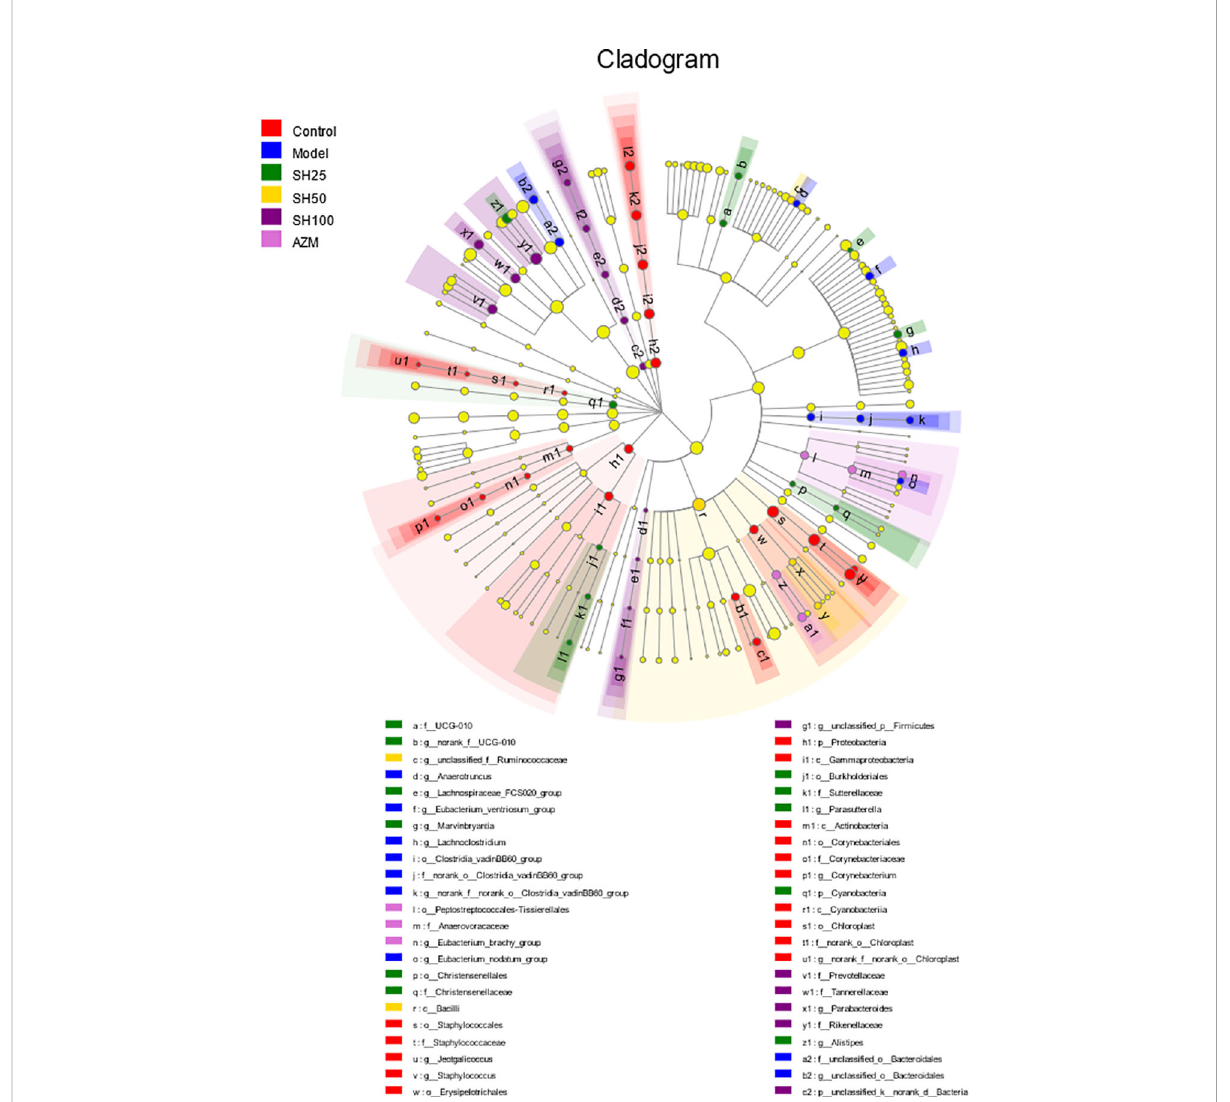
FIGURE 8 Multilevel species hierarchy tree diagram for LEfSe analysis. Different color nodes represent the microbial groups that are signi fi cantly enriched in the corresponding groups and signi fi cantly in fl uence the differences between groups. The pale yellow nodes indicate the microbial groups that have no signi fi cant difference among different groups or have no signi fi cant effect on the difference between groups. SH25, SH50 and SH100 mean SH 25 mg/kg, SH 50 mg/kg and SH 100